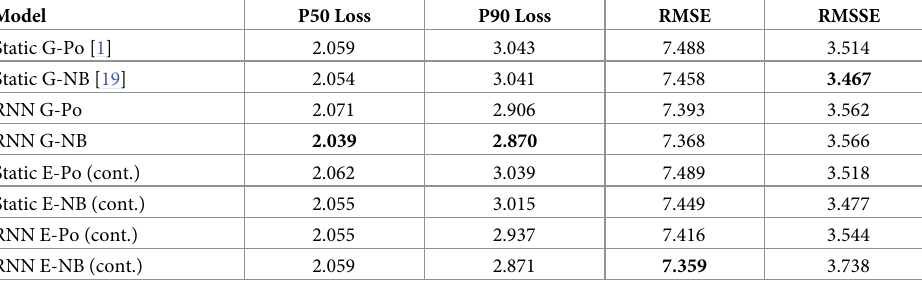
Table 9. Experiment results for continuous-time